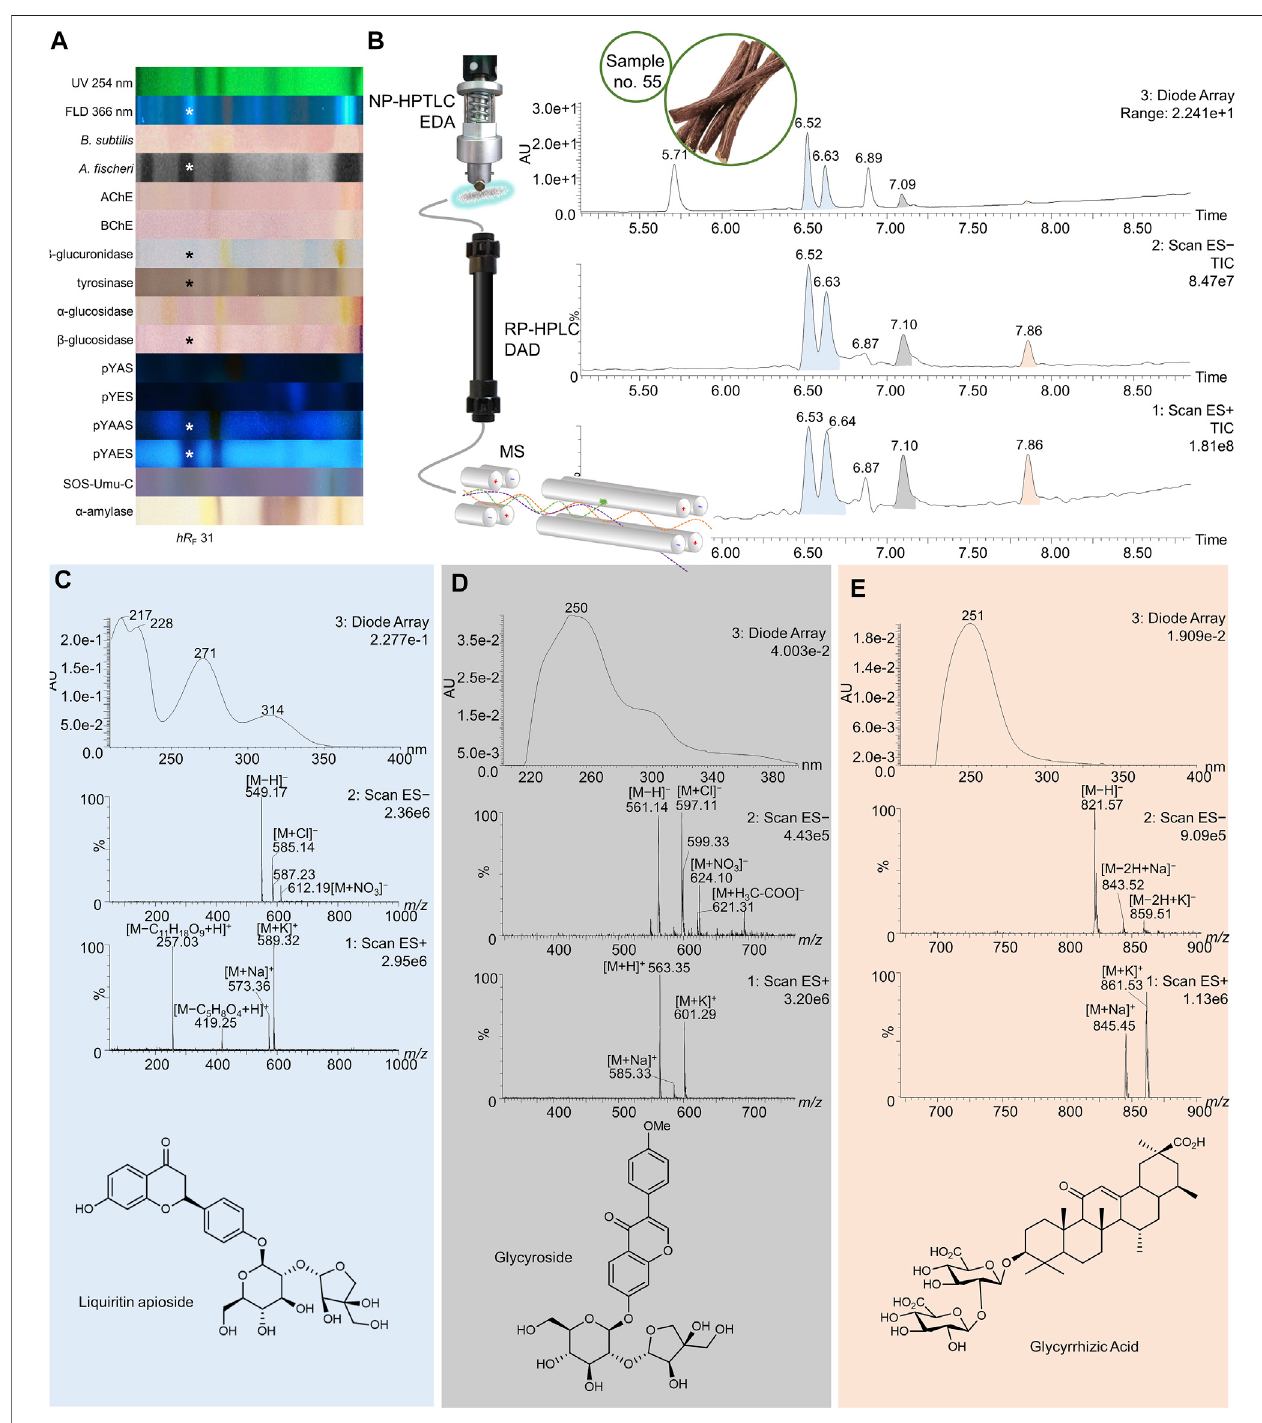
FIGURE 8 | NP-HPTLC − UV/Vis/FLD − EDA − heart-cut RP-HPLC − DAD − HESI-MS analysis of licorice no. 55. NP-HPTLC − UV/Vis/FLD − EDA analysis as in Figure 4 (A) , followed by heart-cut elution of the bioactive zone at hR F 31 (marked*) directly out of the pYAES bioautogram and online desalting to obtain the RP- HPLC − DAD − HESI-MS chromatograms (B) and respective UV and mass spectra of the peaks at RT 6.53/6.64 min (C) , 7.10 min (D) , and 7.86 min (E) .